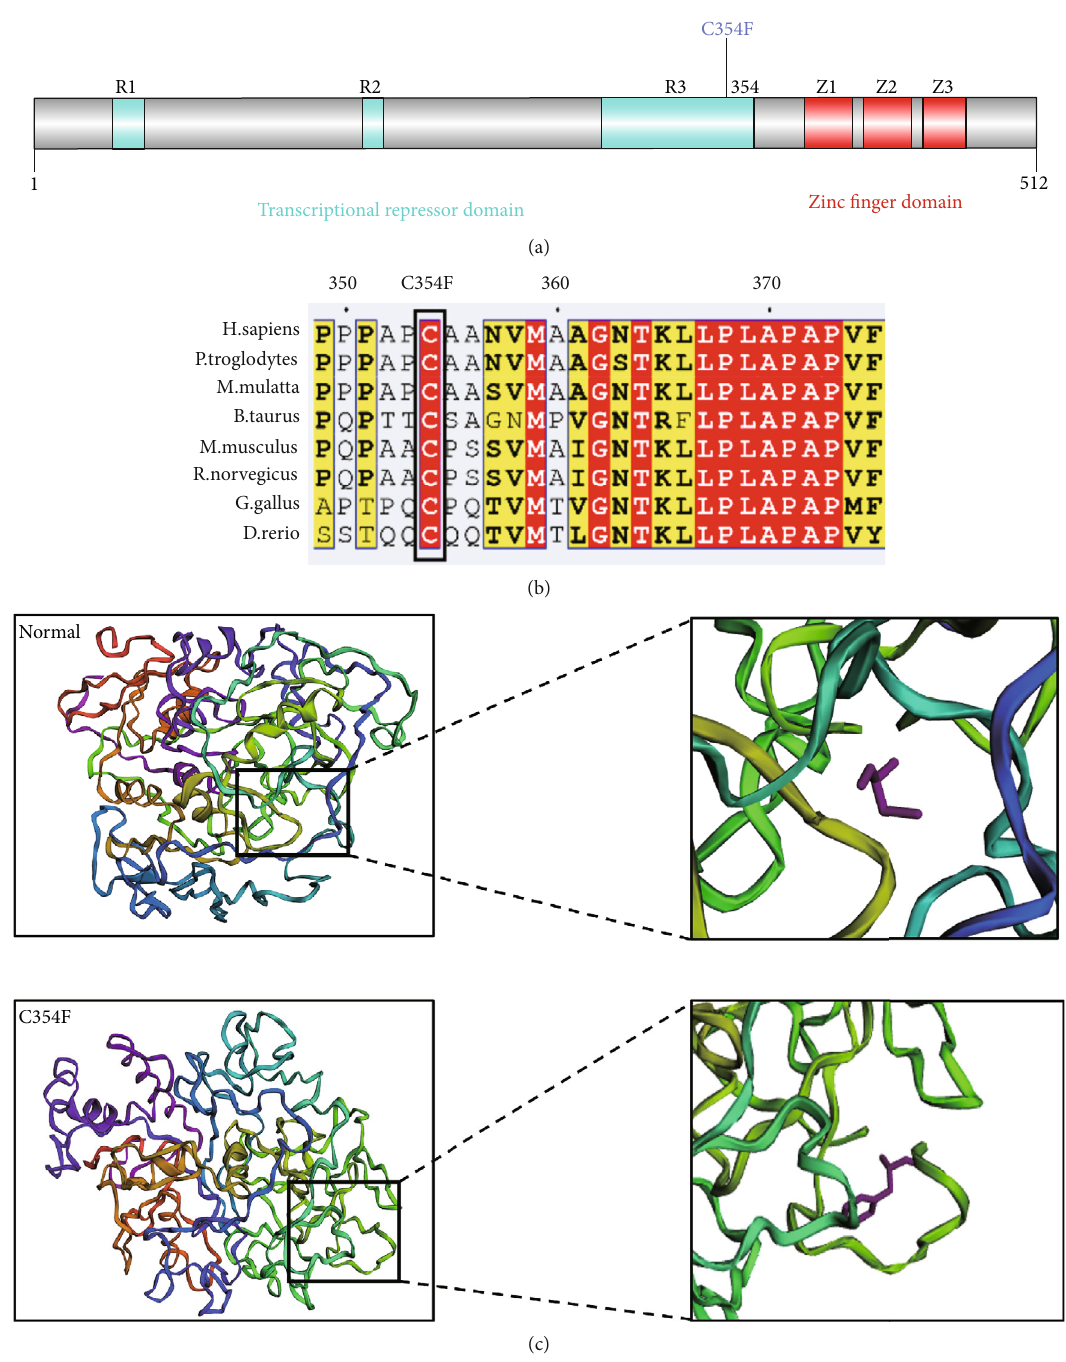
Figure 2: Sequencing analysis and 3D structure of the mutant protein. (a) KLF11 structure domains. Mutations at the protein level are indicated below the 3RDB domain. (b) Cross-species conservation of Cys354Phe-KLF11. (c) Protein structure prediction of KLF11 (WT and